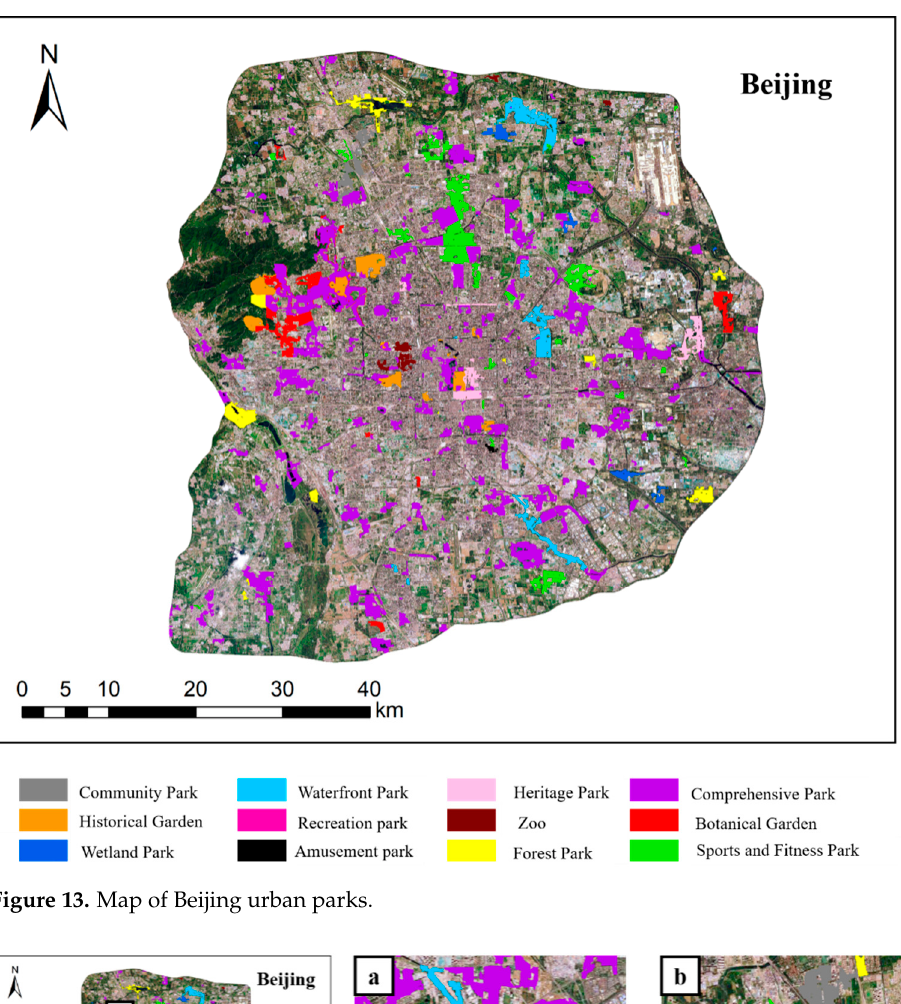
Figure 13. Map of Beijing urban parks.